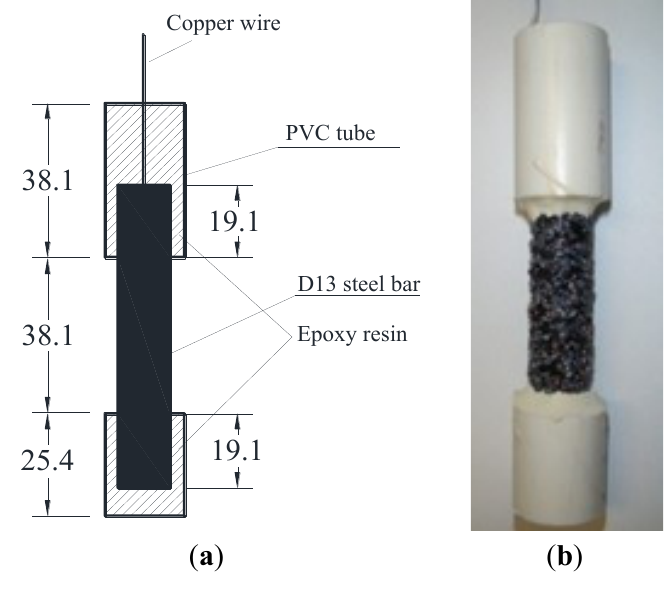
Figure 9. Geometry of steel bar samples: ( a ) sample dimensions; and ( b ) sample ready for test (unit: mm). Copper wire